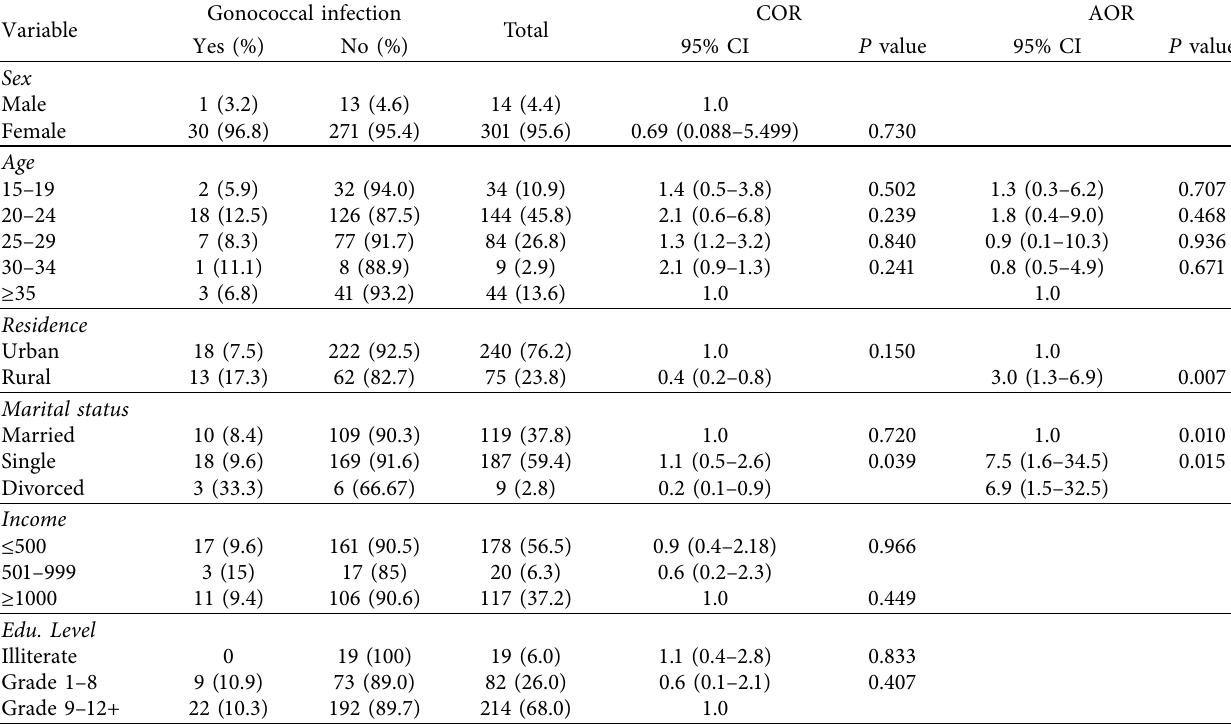
Table 1: Description of the demographic data of patients investigated for gonococcal infection at Jimma Town Private Clinics, Jimma, Ethiopia.